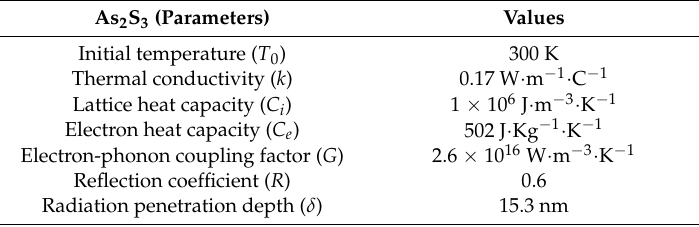
Figure 4. The relationship between surface temperature and depth of the material at different delay times, ( a ) 8.26 mJ/cm 2 , ( b ) 18.58 mJ/cm 2 , ( c ) 30.98 mJ/cm 2 , respectively. Table 1. Parameters forAs 2 S 3 used in heat calculation [38–42].